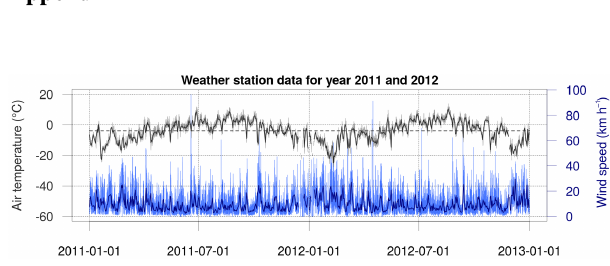
Figure A1. Time series of the in situ installed Vaisala WXT520 weather station providing air temperature and wind speed for the years 2011 and 2012. The 10min averages are shown in gray (air temperature) and light blue (wind speed), whereas weekly averages are shown in dark gray (air temperature) and dark blue (wind speed). Dashed dark gray line represents the mean temperature.